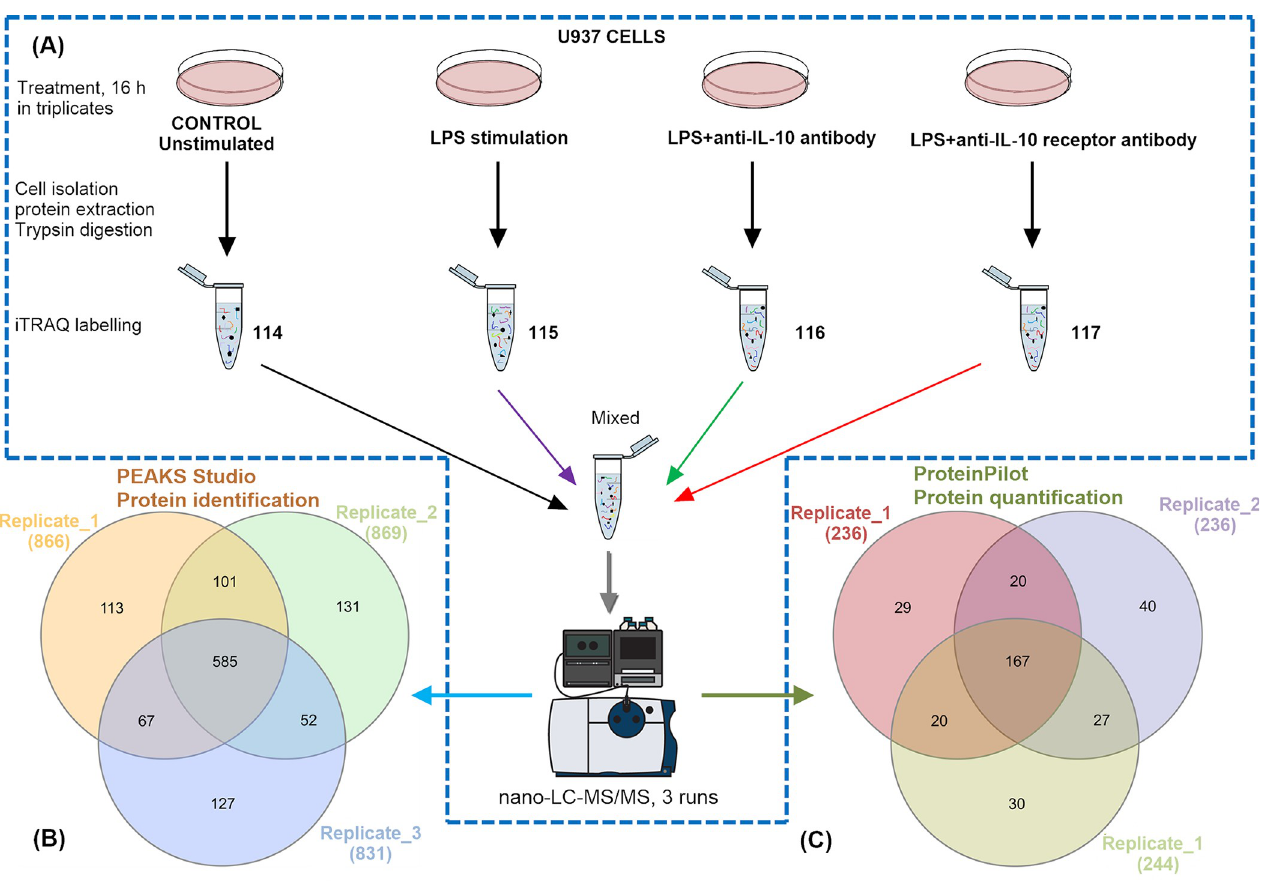
Fig 1. Overall workflow for quantitative proteomic analysis of U937 cells with different treatments, including LPS, LPS plus anti-IL-10 antibody and LPS plus anti-IL-10 receptor antibody. (A) Untreated and treated cell proteins/peptides were extracted and labelled with iTRAQ 4-plex reagent, followed by identification and quantification with high-accuracy nano-LC TripleTOF MS. (B) The comparison of proteins identified from three replicates (including proteins supported by both labelled and unlabelled peptides). (C) The comparison of quantifiable proteins in three replicates. See S1 and S2 Tables for more